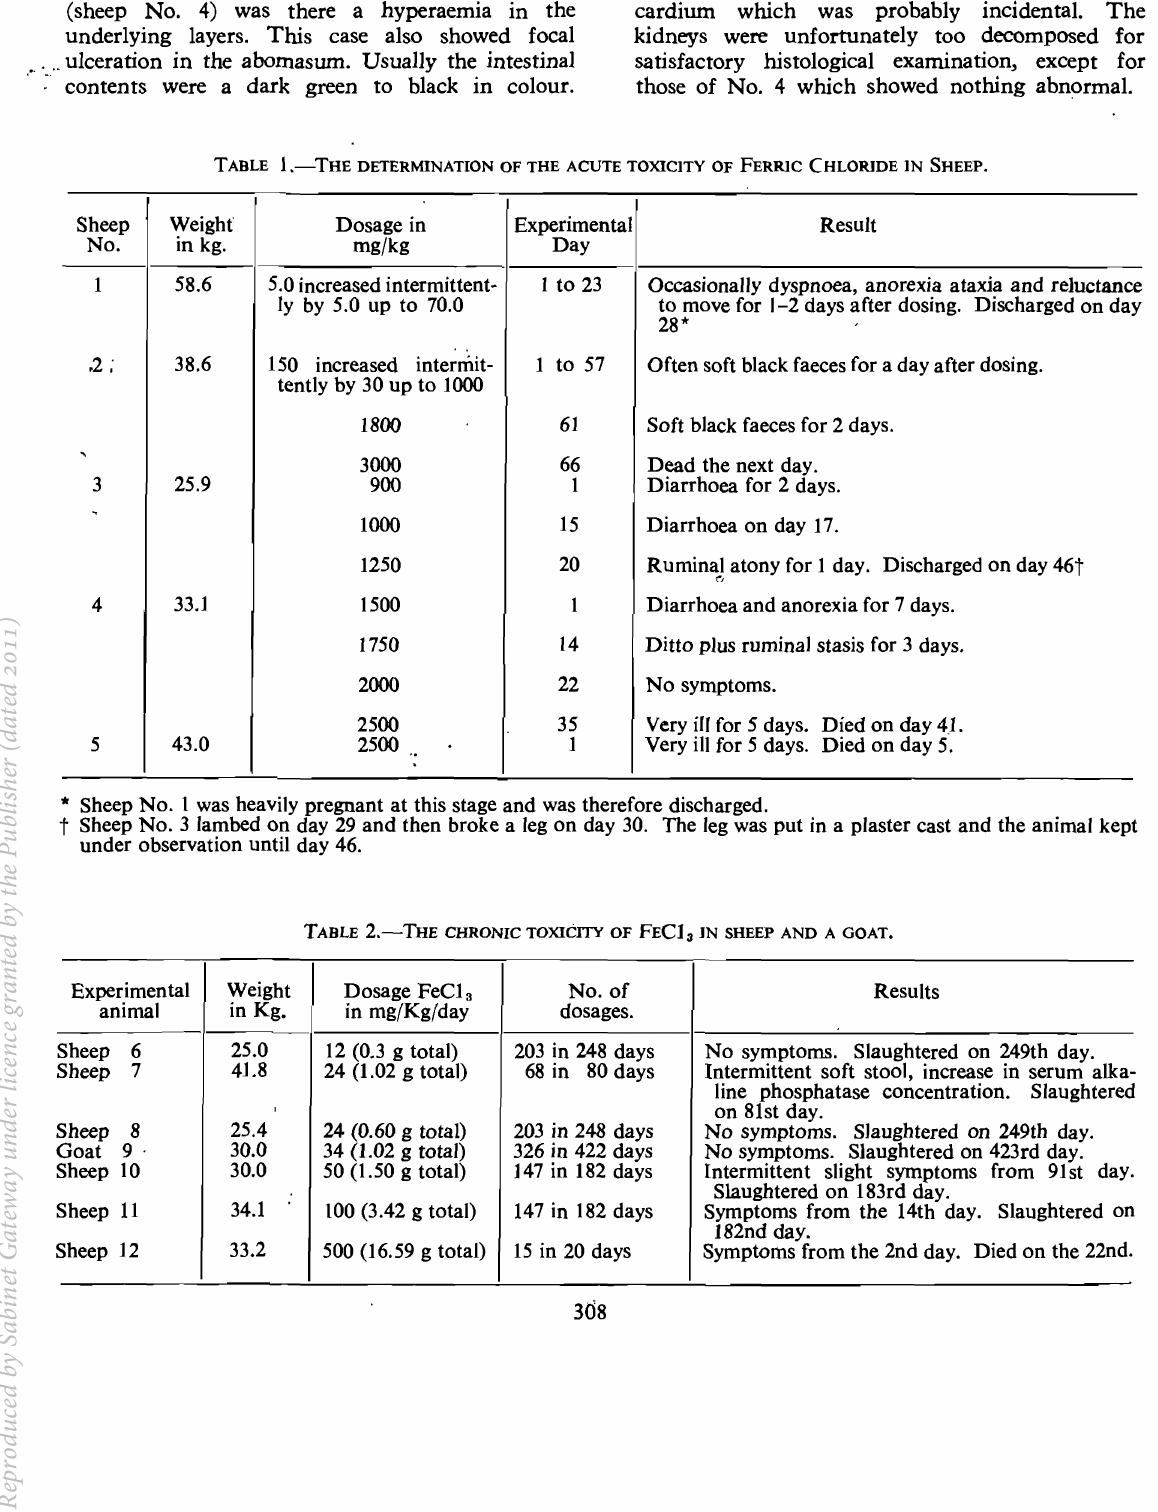
TABLE i.-THE DETERMINATION OF THE ACUTE TOXICITY OF FERRlC CHLORlDE IN SHEEP. Sheep